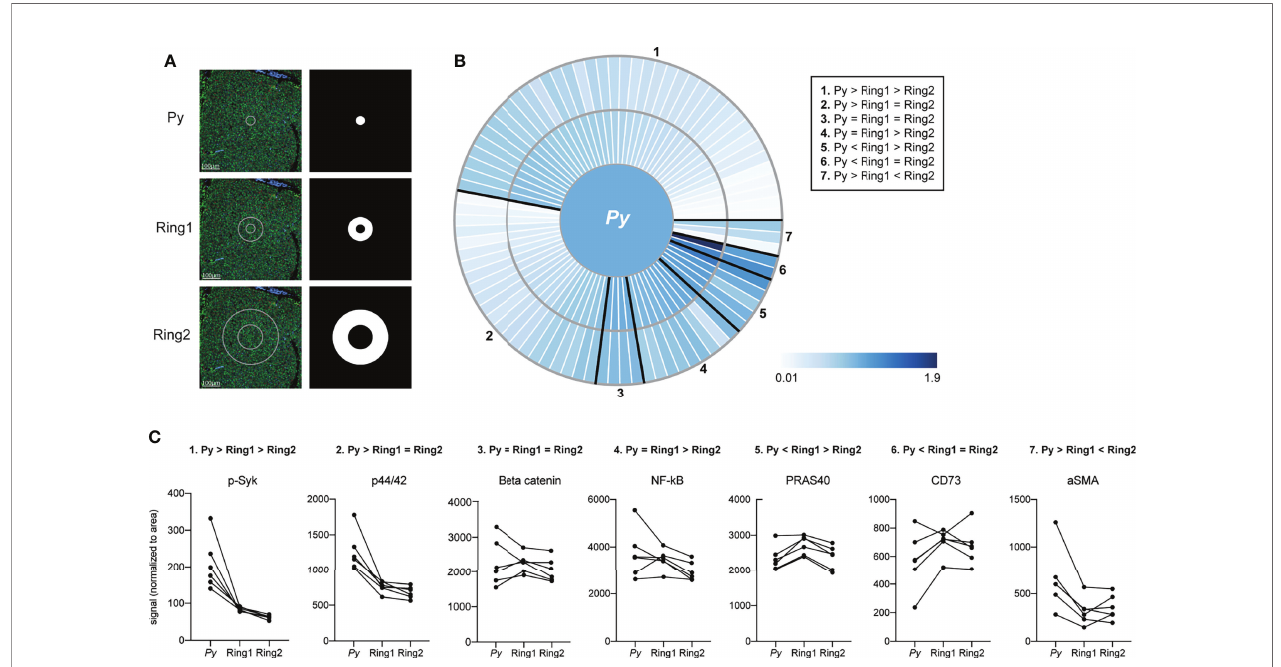
FIGURE 3 | Signals are altered in rings surrounding Plasmodium -infected hepatocytes. (A) Representative images of fl uorescent staining of liver sections and region of interest (ROI) masks. (B) Heat maps showing fold change in protein levels between ring ROIs. Signal was normalized to ROI area and to the infected cell ROI, set at 1. Proteins showing similar relative patterns of expression across rings are grouped together and outlined in black. (C) Area normalized signal of antibodies illustrative of each spatial pattern. Lines connect matched infected cell and ring ROIs. n= 6 matched ROI sets from a single